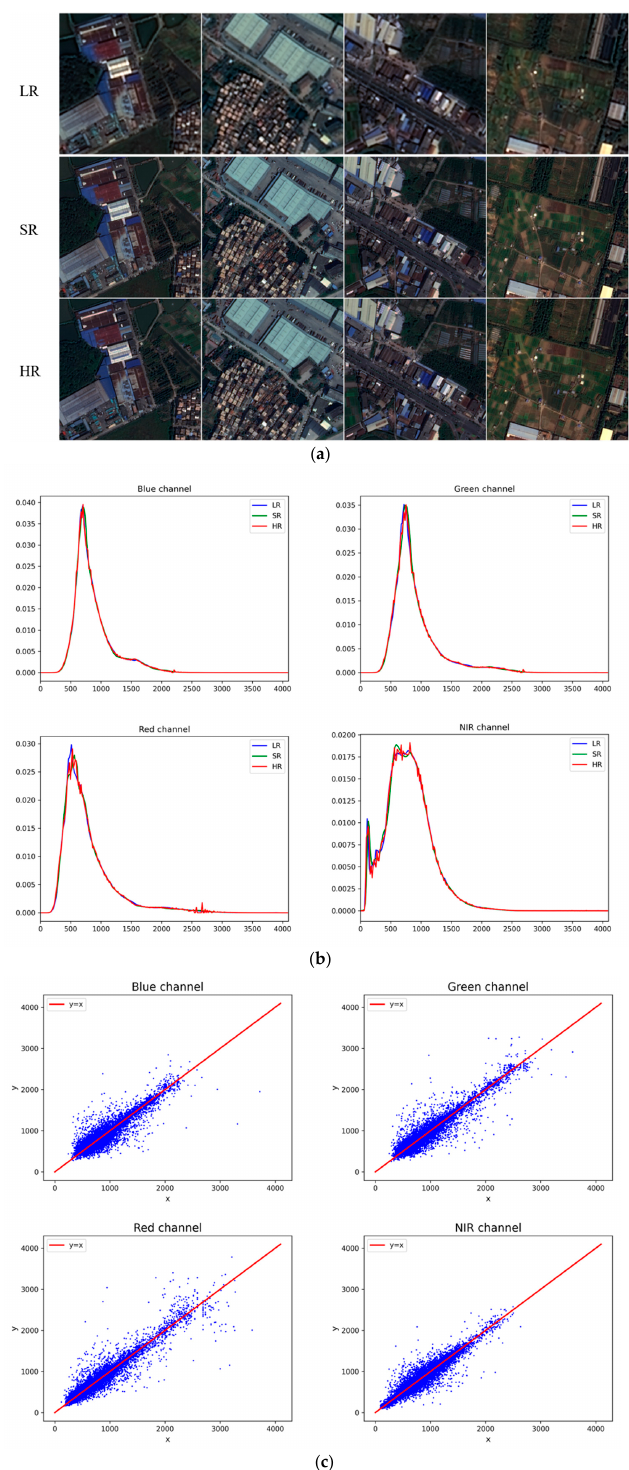
Figure 12. Validation of the preservation of the spectral properties on our dataset after relative radiometric correction: ( a ) the LR and HR images after relative radiation corrected, and SR results for the retrained model; ( b ) histogram of different bands of LR, HR, SR, where the X-axis represents the reflectance value, and the Y-axis represents the frequency of that reflectance; ( c ) pixel reflectance values of HR, SR scatter plot of reflectance of SR. The x-axis represents the HR reflectance, and the y-axis represents the SR reflectance.